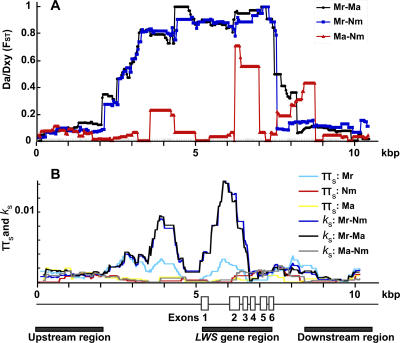
Detection of Selection Pressure on the LWS GeneThe genome structure of the LWS gene and its flanking region and (A) sliding-window analysis of FST between Marumbi (Mr., station 2: N. greenwoodi), Namatembi (Nm., station 15: N. greenwoodi), and Makobe (Ma., station 10: N. omnicaeruleus) populations (Marumbi versus Makobe, Marumbi versus Namatembi, and Makobe versus Namatembi indicated by black, blue, and red lines, respectively).(B) Sliding-window analysis of silent polymorphism (πs) in Marumbi (Mr: light blue), Namatembi (Nm: red), and Makobe (Ma: yellow), and silent divergence (ks) between Marumbi, Namatembi, and Makobe populations (Marumbi versus Namatembi, Marumbi versus Makobe, and Makobe versus Namatembi indicated by blue, black, and gray lines, respectively). π s and k
s were calculated for segments of 700 bp in 25-bp intervals. The solid lines under the genome structure of LWS indicate the three regions used in HKA tests (Table S2). The LWS gene region is defined as the sequence between initiation codon and stop codon (2205 bp) of LWS. The up- and downstream regions are defined as the 5′ and 3′ ends of sequences of the same length as the LWS gene region.